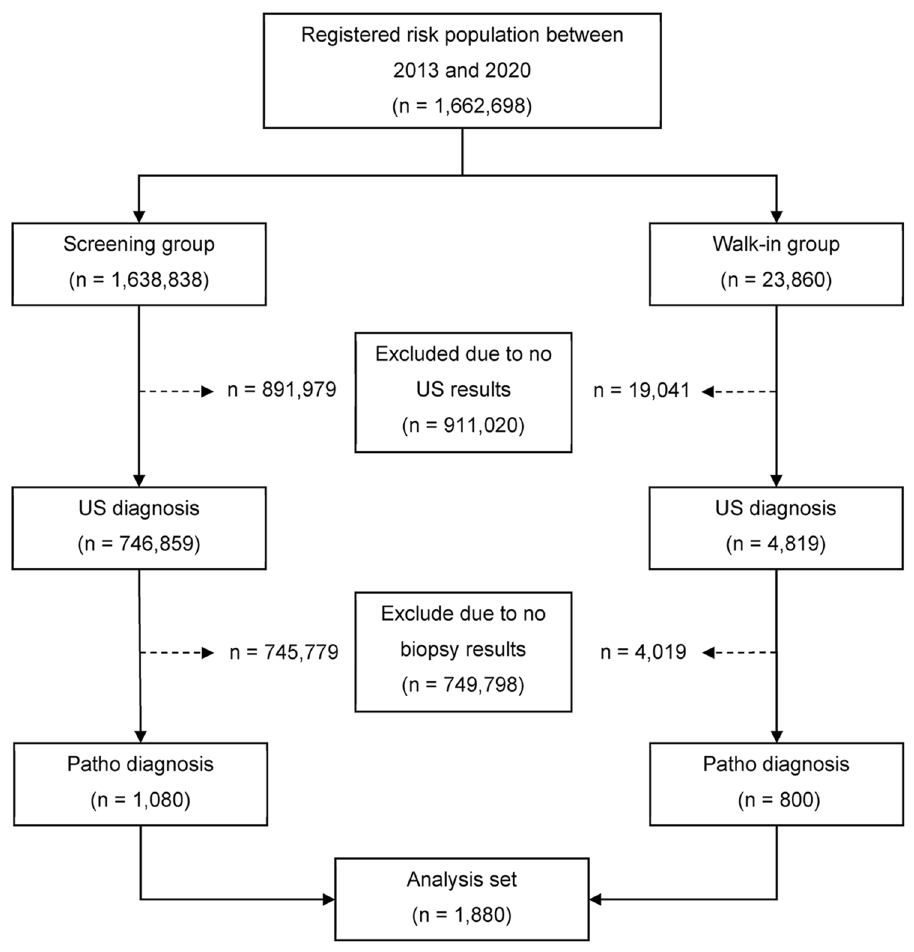
Figure 1. Sample selection process.